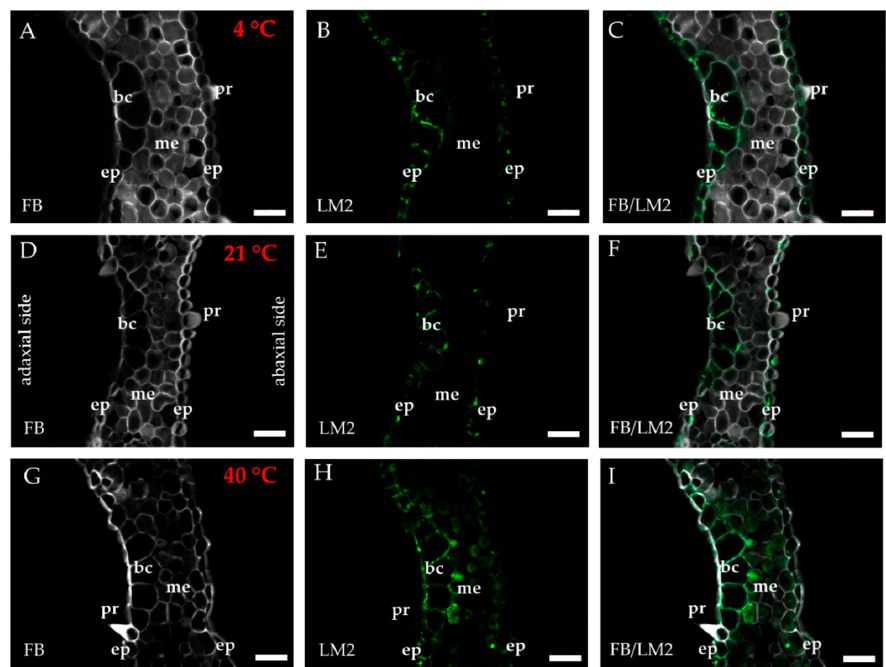
Figure 5. Immunolocalisation of the LM2 epitope ( A – I ) in cross ‐ sections of the B. distachyon leaves, ( A – I ): through the mesophyll and bulliform cells. ( A – C ): 4 °C; ( D – F ): 21 °C; ( G – I ): 40 °C. Abbreviations: bc—bulliform cells, ep—epidermis, FB—fluorescent brightener, me—mesophyll, pr—prickle. The green colour shows epitope occurrence. Scale bars: 20 μ m.